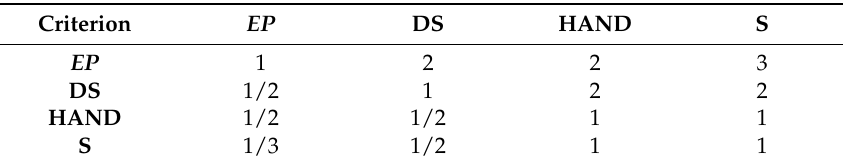
Table A3. Pairwise comparison for flood hazard S3.